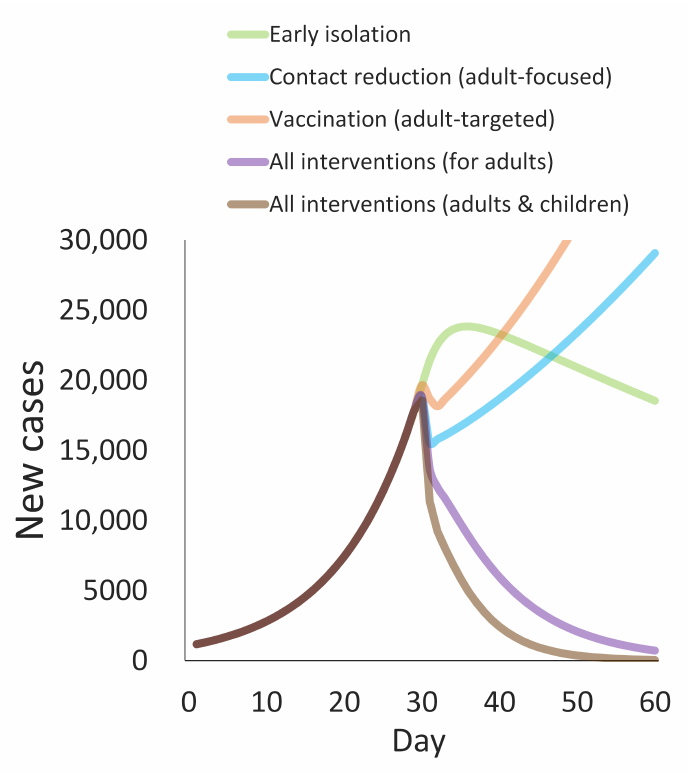
Figure 3. Synergistic effect of public health interventions to control the spread of the Omicron variant. Simulated epidemic curves for the Omicron variant with implementing a single public health intervention or their combination on day 30 are